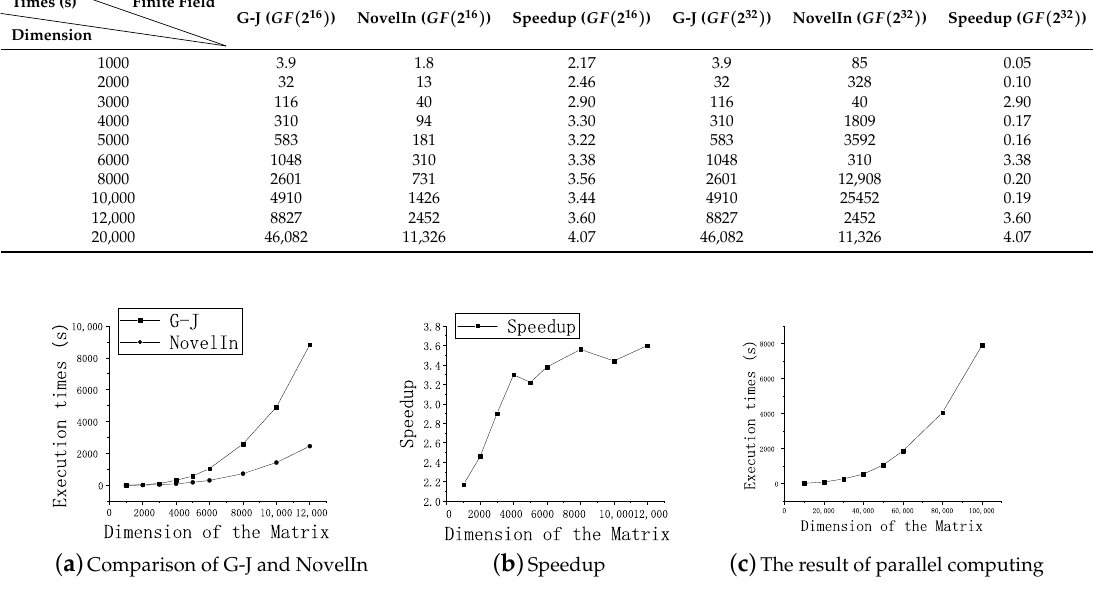
Figure 4. The comparison of G-J and NovelIn and NovelIn’s performance on GF ( 2 16 ) .